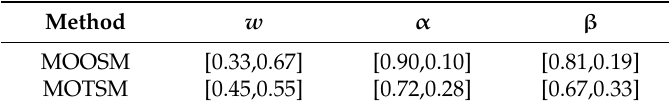
Table 3. The weight information of two methods.